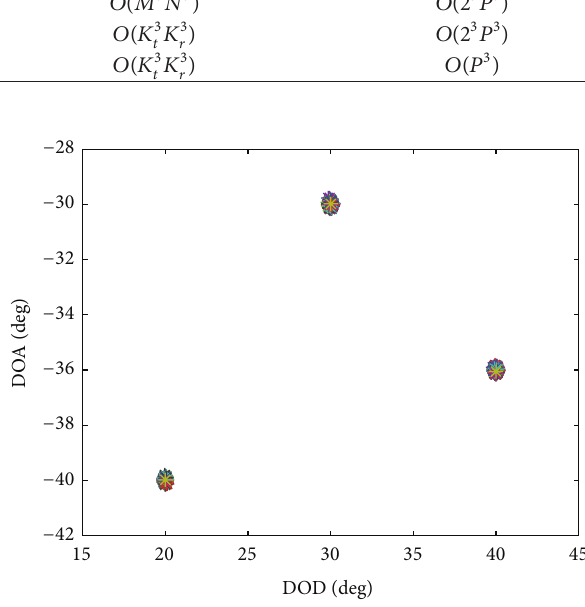
Table 1: Comparison of computational complexities of the beamspace unitary ESPRIT, the beamspace ESPRIT, and the unitary ESPRIT. Algorithms